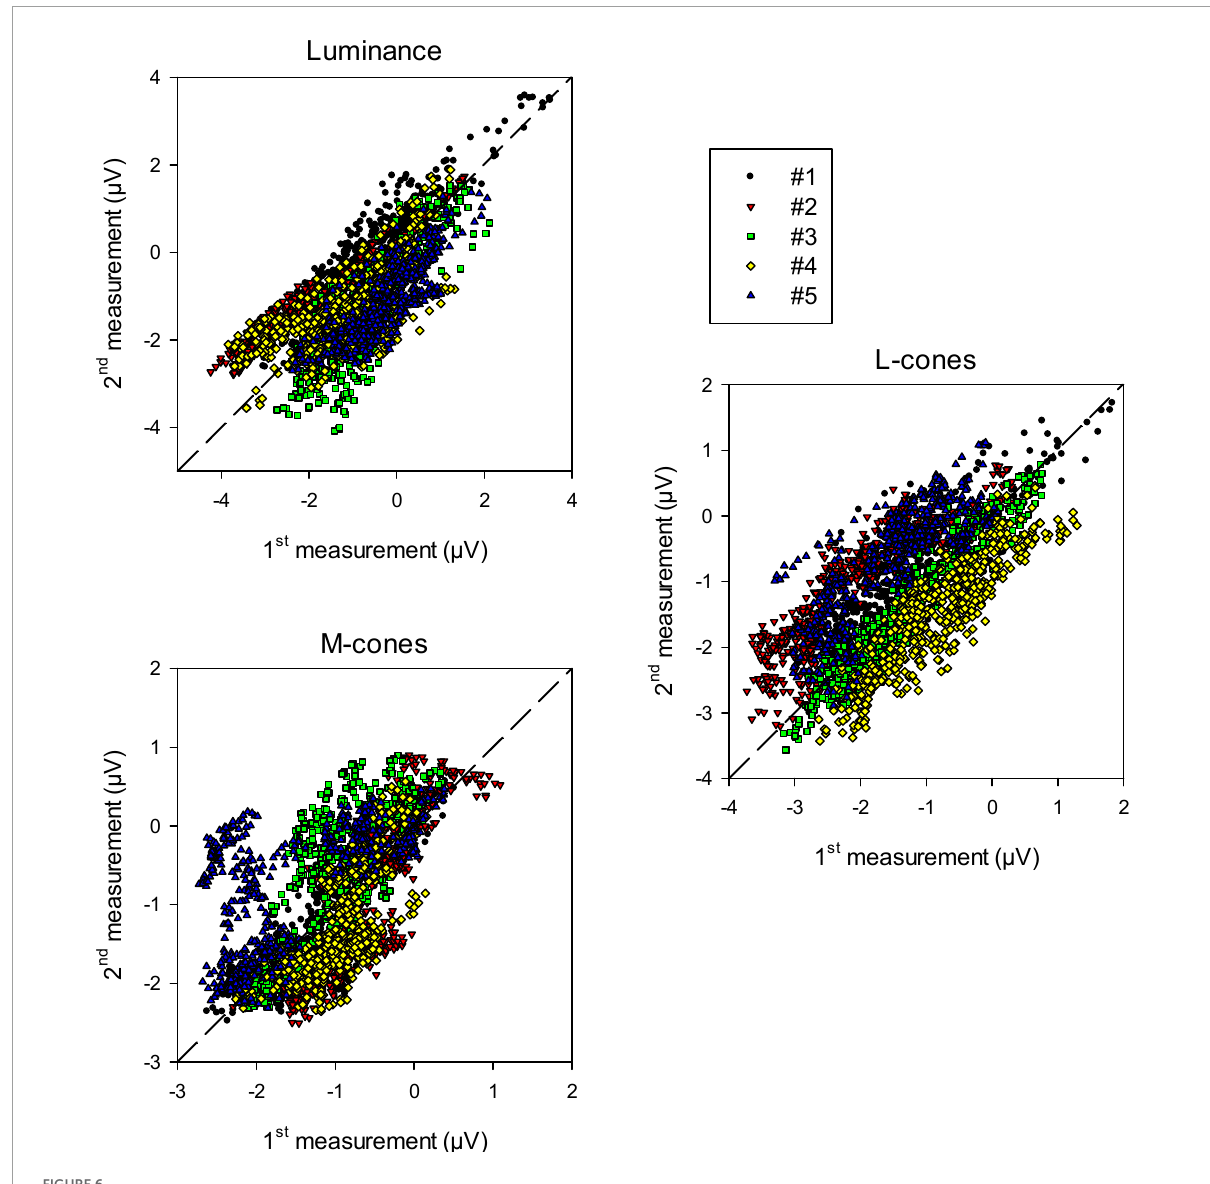
We performed linear regressions on each data